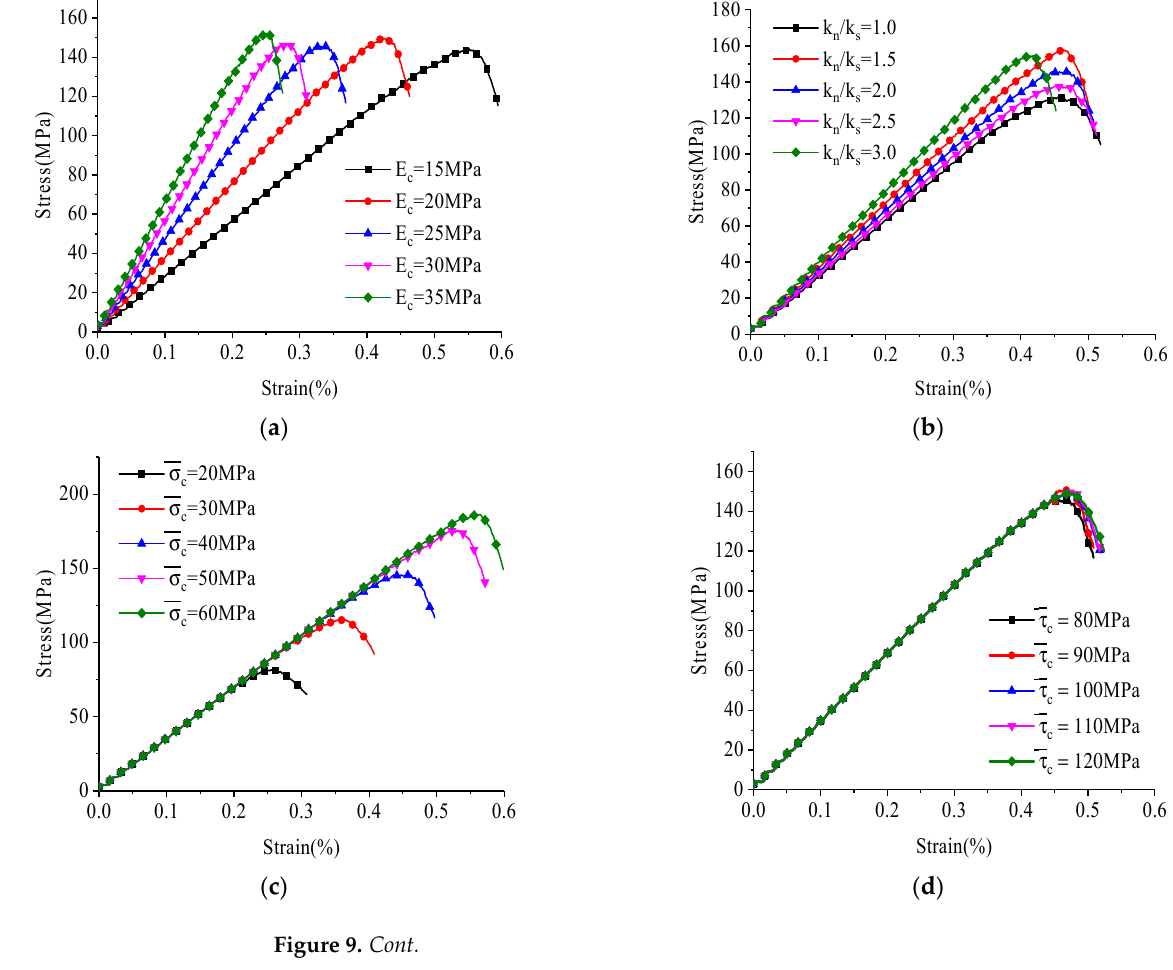
( e ) Figure 9. Sensitivity analysis for unknown microparameters in uniaxial compression test. ( a ) Pa- rameter 𝐸 (cid:3030) ; ( b ) Parameter 𝐾 (cid:3041) 𝐾 (cid:3046) ⁄ ; ( c ) Parameter 𝜎(cid:3364) (cid:3030) ; ( d ) Parameter 𝜏̅ (cid:3030) ; and ( e ) Parameter μ .